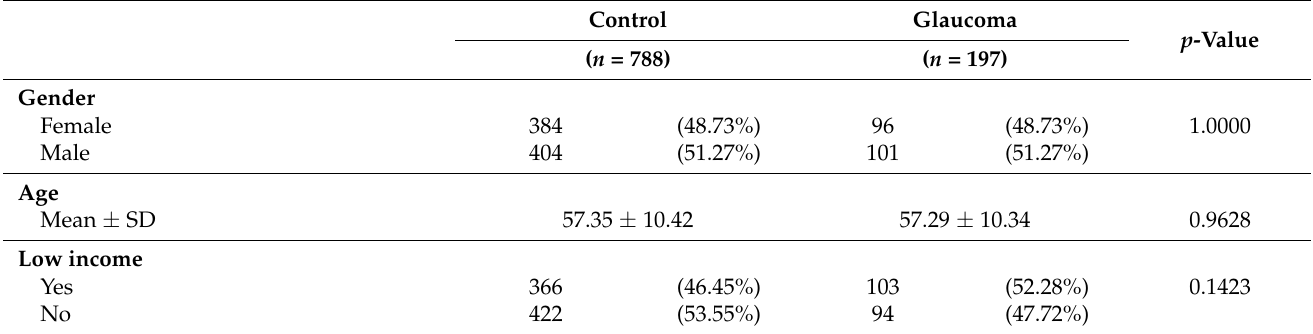
Table 1. Glaucoma and control from 2008 to 2013 in diabetes